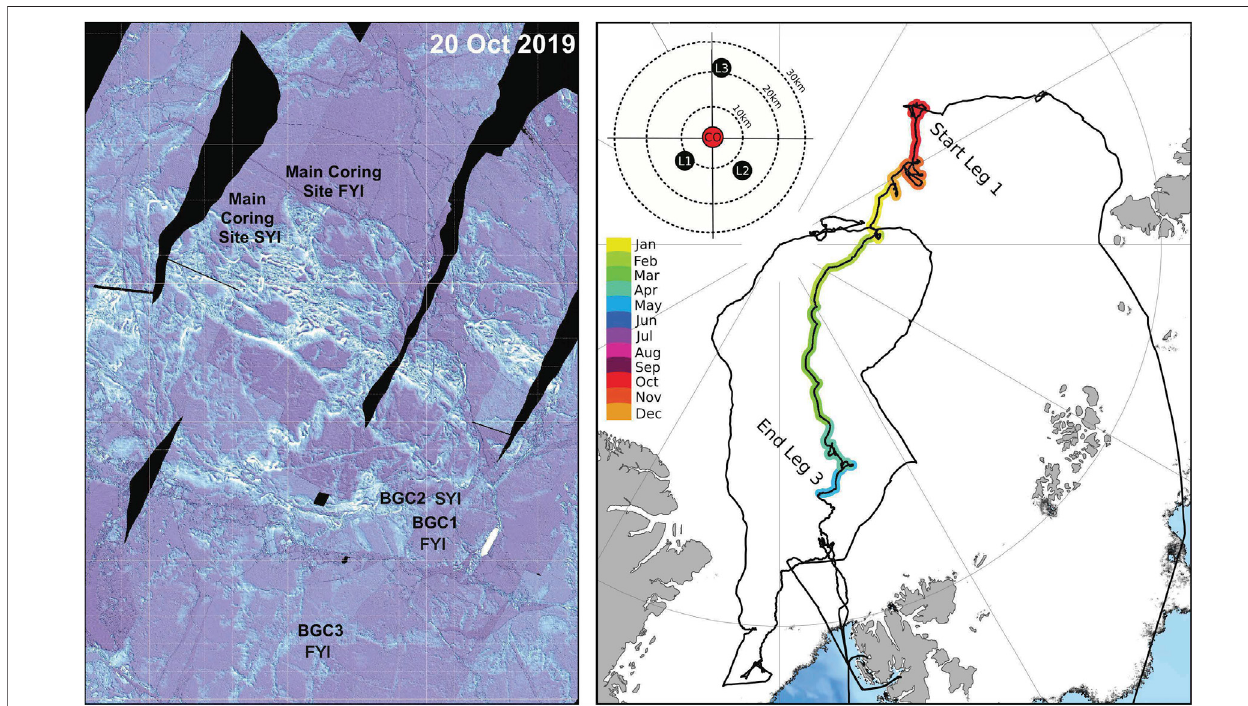
FIGURE1| Leftpanel:CentralObservatorymapof20October2019generatedfromhelicopterlaserscannersurveys(credit:StefanHendricks).Brightershadesof blueindicatelargersurfaceelevation,i.e.pressureridgescanbeseenaswell.ThemaincoringandBioGeoChemistry(BGC)FYIandSYIsiteswereonthesame fl oefrom late October 2019 to early May 2020, but their relative positions changed due to local ice movements. Right panel: The RV Polarstern MOSAiC track is shown by the black line and the drift trajectory from legs 1 to 3 by the coloured segments, modi fi ed from Nicolaus et al. (2022). The background shows the sea ice extent for March 2020.Inthetopleftofthepanel, thepositionoftheCentral Observatory(CO) inthered circlerelativetotheLsitesoftheDistributedNetwork for22October2019 is shown and modi fi ed from Krumpen and Sokolov (2020).